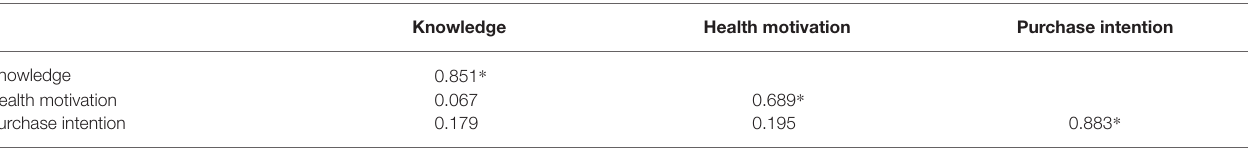
TABLE 3 | Average variance extracted and correlation of